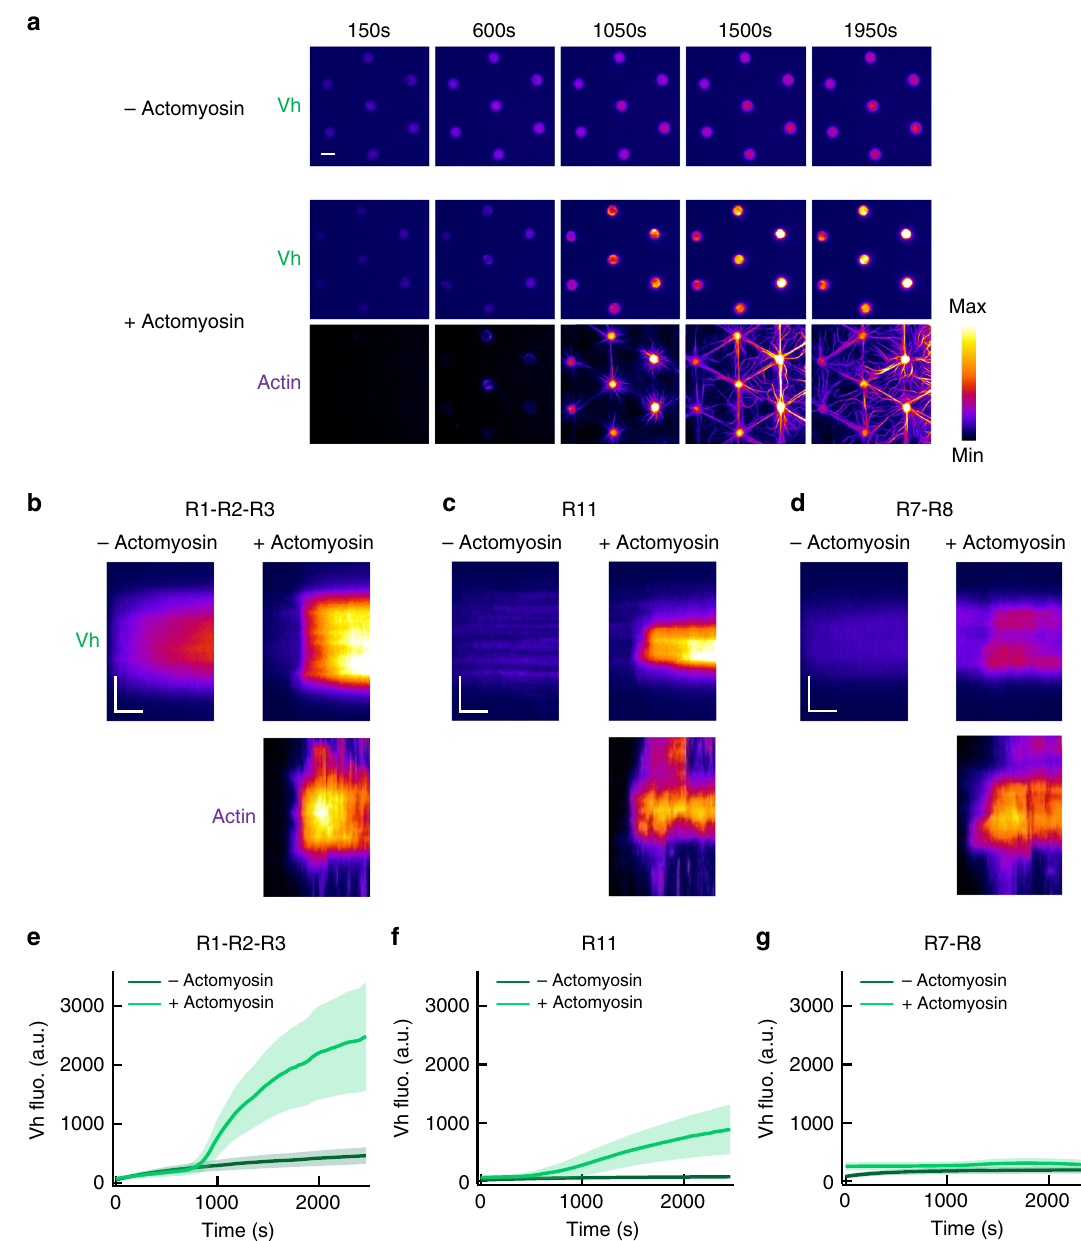
Fig. 2 Talin domains bind to vinculin differently in response to the actomyosin force. a Time lapses showing the recruitment of Vh to talin R1 – R2 – R3- coated disks in the absence (top) or presence of actomyosin (Vh is shown on the middle and actin on the bottom panel). This experiment was repeated fi ve times independently with the same results. b – d Kymographs of EGFP-Vh (top) and actin (bottom) along a cross-section of a disk coated with talin R1 – R2 – R3 ( b ) or R11 ( c ) or R7 – R8 ( d ) in the absence (left) or presence (right) of actomyosin. Conditions: 100 nM EGFP-Vh, 2.4 µ M actin (2% Alexa594- labeled), 50 nM myosin, and 1 µ M talin during the coating step. The images are color coded using the fi re LUT of ImageJ. Scale bar in time lapses = 10 µ m. In kymographs, horizontal bar = 500 s, vertical bar = 5 µ m. e – g Kinetics of the mean fl uorescence of EGFP-Vh corresponding to the conditions described in ( b – d ). Data are mean ± SD. e n = 80 ( − actomyosin), n = 60 disks ( + actomyosin). f n = 60 ( − actomyosin), n = 75 disks ( + actomyosin). g n = 80 ( − actomyosin), n = 76 disks ( + actomyosin). Source data are provided as a Source data fi le. See Supplementary Movie 1, Supplementary Movie 2, and Supplementary Movie